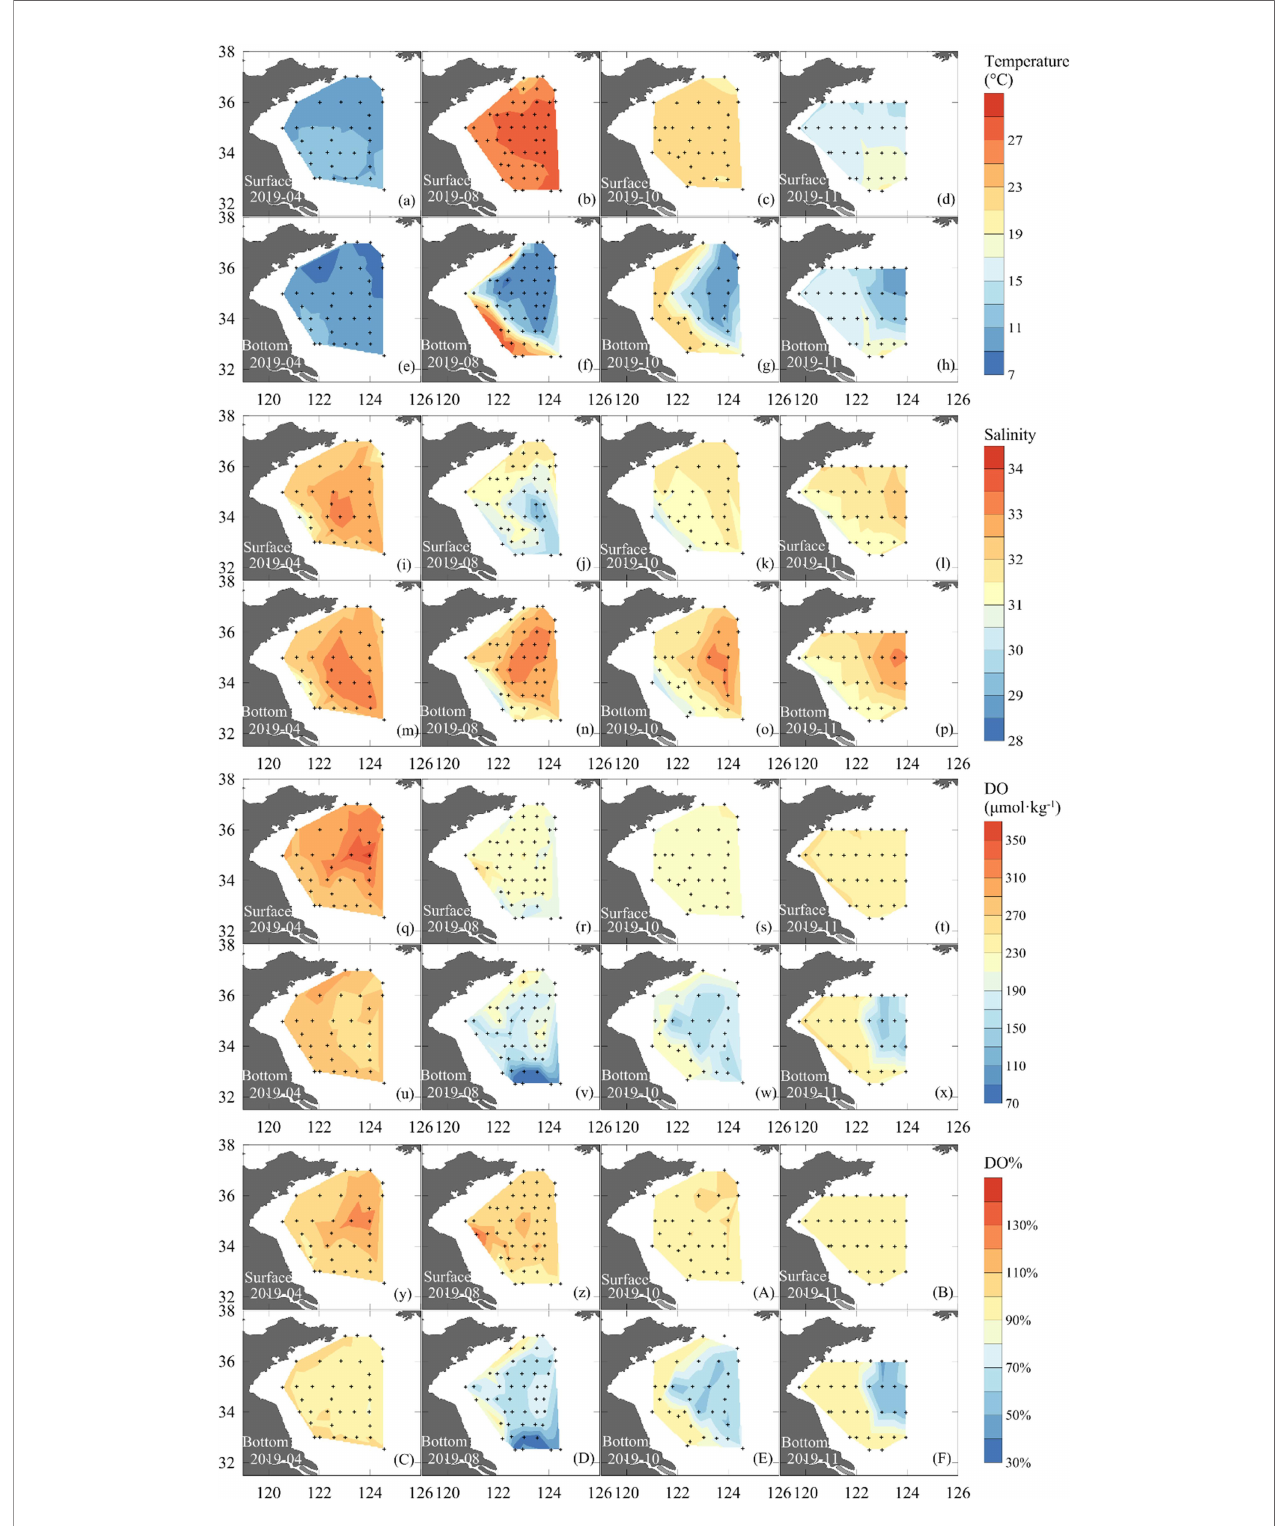
FIGURE 3 | Surface and bottom distribution of water temperature (a-h) , salinity (i-p) , DO (q-x) , and DO% (y-z, A-F) during seasonal mapping cruises carried out in 2019.